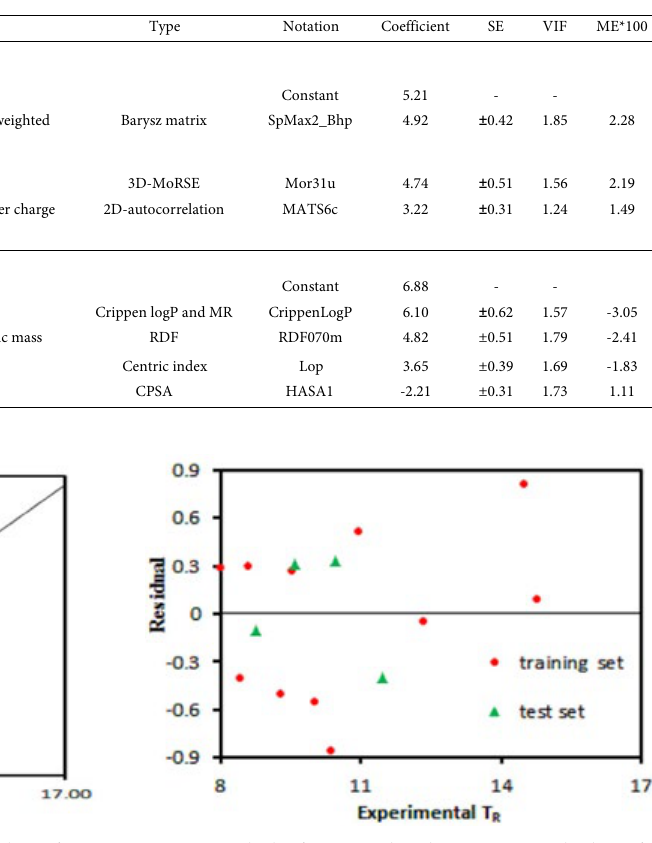
Fig. 1. Plot ACM predicted vs. experimental values of retention time.